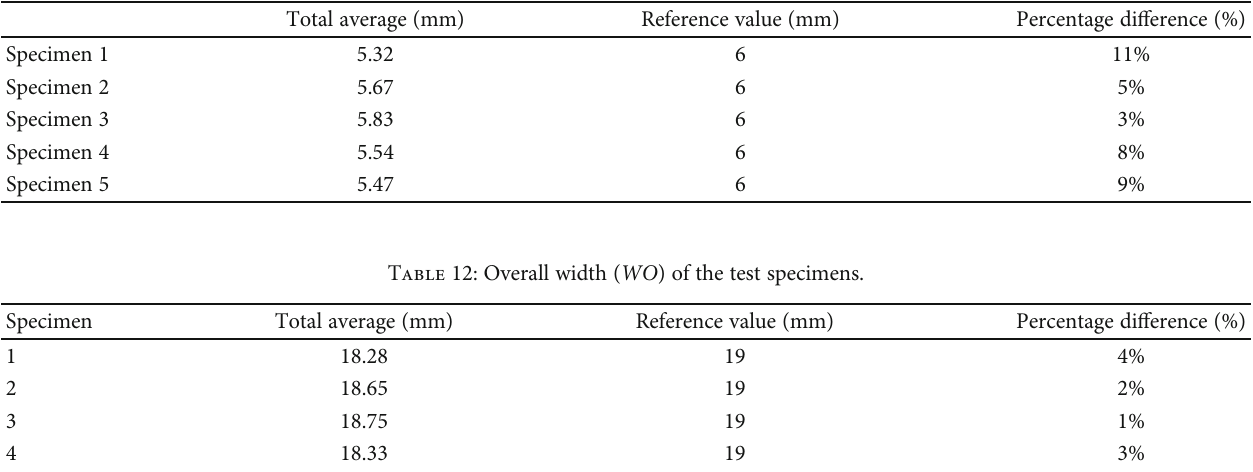
Table 11: Width ( W ) of the gauge length of the test specimens.